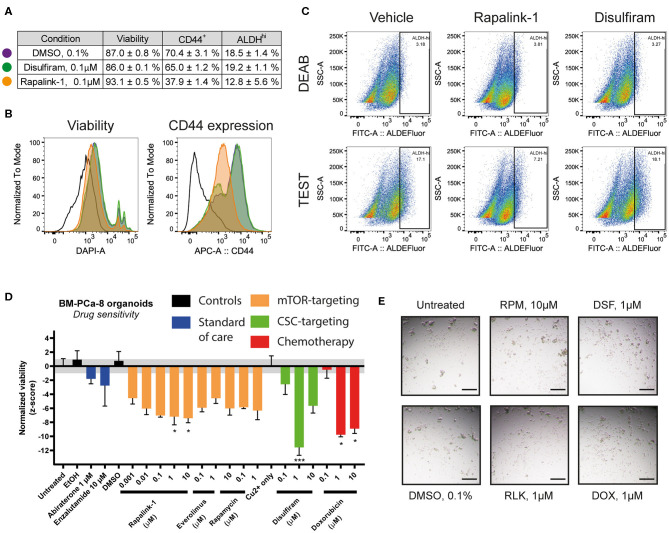
(A) Summary table of viability values and of CD44+ and ALDHHi cells in LAPC9 organoids cultures treated with DMSO 0.1% (purple circle), disulfiram 0.1 μM (green circle) or Rapalink-1 0.1 μM (orange circle) for 48 h before analysis via flow cytometry. Data are reported as mean ± SEM, N = 2–5. (B) Representative ALDEFluor staining dot plots for ALDHHi determination reported in (A); open histogram, unstained; purple, DMSO; green, disulfiram; orange, Rapalink-1. Rapalink-1 reduced the ALDHHi population of cells, although not significantly. (C) Representative viability and CD44 expression plots of data reported in (A). Treatment of LAPC9 organoids with Rapalink-1 for 48 h significantly increased viability and reduced CD44 expression (p < 0.0001 for both analyses). Color code for the histograms is the same as reported in (A). Drug screen assay on prostate bone metastasis organoids from sample BM-PCa-8. Organoids were seeded and allowed to form for 48 h before treating with the reported drugs for 48 h. (D) Viability values of organoids across the various tested conditions were normalized and shown. The grayed area corresponds to the expected distribution of the reference condition (untreated). Standard of care drugs (blue) were not effective treatments in vitro at the tested concentrations, while among the mTOR-targeting drugs (orange) the highest concentrations of rapalink-1 significantly reduced organoids viability after 48 h of treatment. Treatment with doxorubicin (1, 10 μM, red) as well as with the cancer stem cell-targeting drug disulfiram (1 μM, with 1 μM copper gluconate, green) significantly reduced PCa bone metastasis organoids viability. Data were analyzed by one-way ANOVA, treated conditions were compared to vehicle (DMSO). N = 2; *p < 0.05; ***p < 0.001. (E) Representative images of BM-PCa-8 organoids after 48 h of treatment with the indicated drugs. Scale bars, 200 μm.